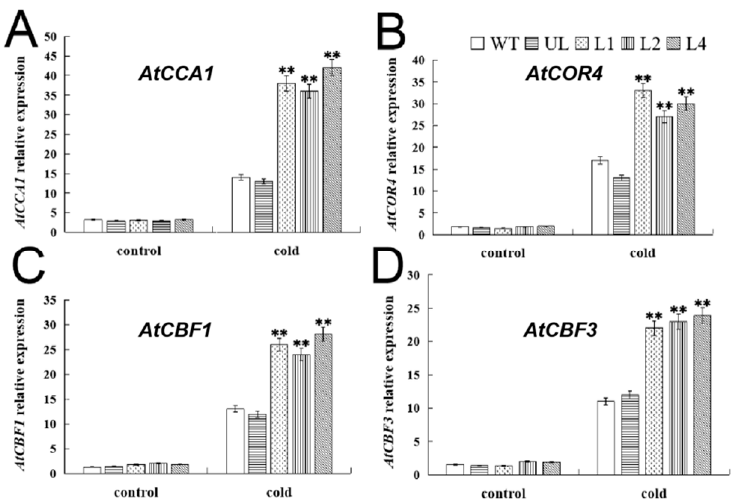
Figure 10. The expression levels of genes related to cold stress in each strain. Relative expression levels of ( A ) AtCCA1 , ( B ) AtCOR4 , ( C ) AtCBF1 and ( D ) AtCBF3 . SD is represented by error bars. The data are the averages of three tests. ** SD with WT, p ≤ 0.01.